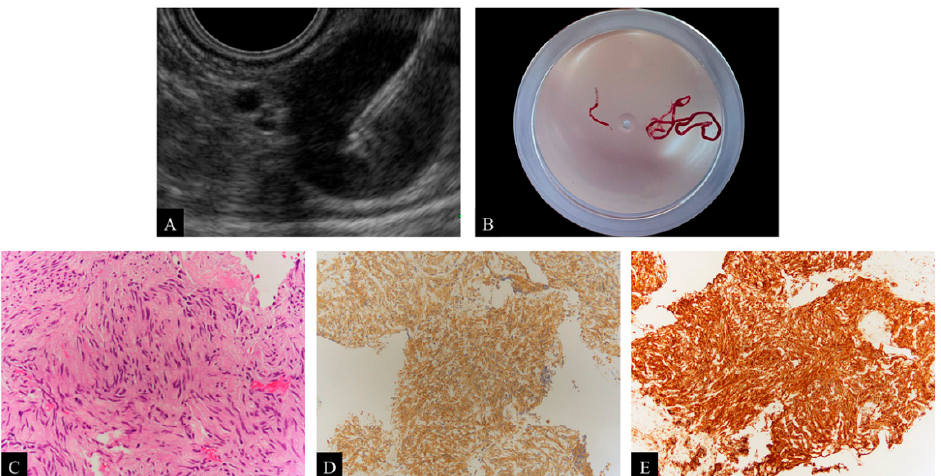
Figure 2. ( A ) Endoscopic ultrasound-guided fine needle aspiration (EUS-FNA) for subepithelial lesions (SELs) with the Franseen needle. ( B ) Visual confirmation of the presence of thin, whitish specimens after EUS-FNA with the Franseen needle. ( C ) Image showing a spindle cell tumor after hematoxylin and eosin (H&E) staining of the obtained specimens, × 200. ( D ) Immunohistochemical staining with c-kit is positive, × 100. ( E ) Immunohistochemical staining with CD34 is positive, × 100. Based on these pathological evaluations, the diagnosis is a gastrointestinal stromal tumor (GIST).